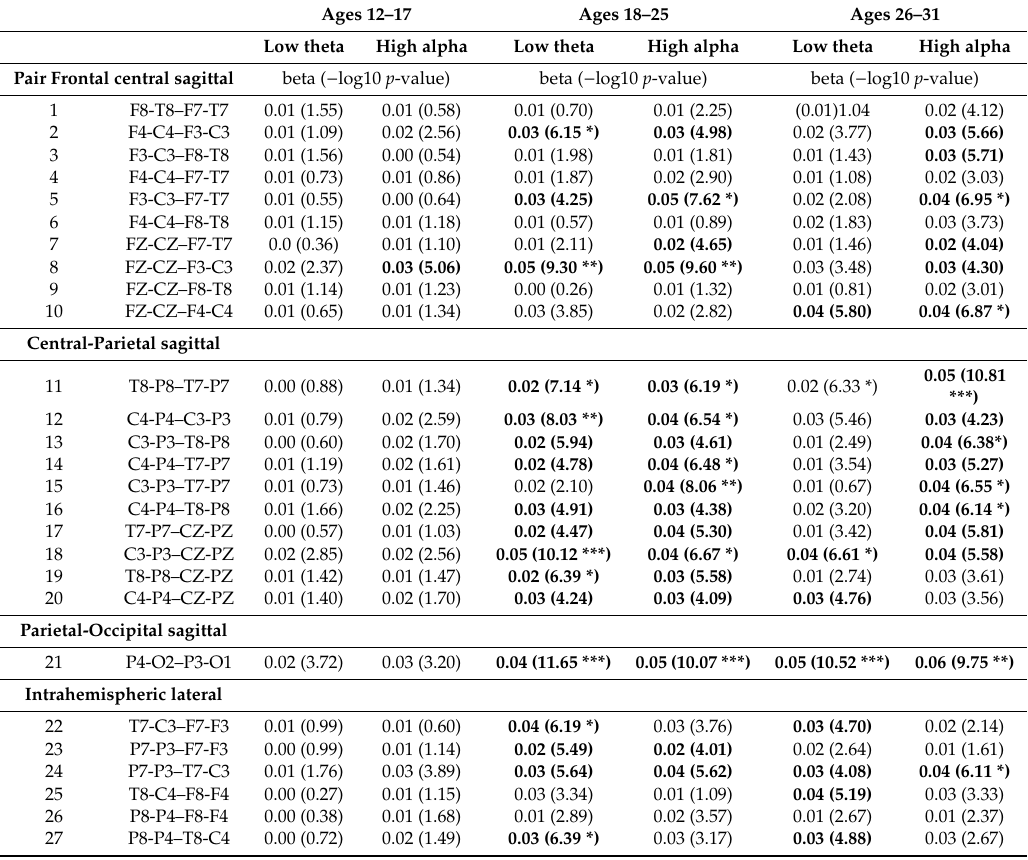
Table 2. First quartile of association beta coe ffi cients and p -values of AD PRS ( p -threshold < 0.001) with low theta and high alpha EEG coherence in males ages 12–31 with − log10 transformation. All values in bold meet the false discovery rate criterion of 10 − 4 .